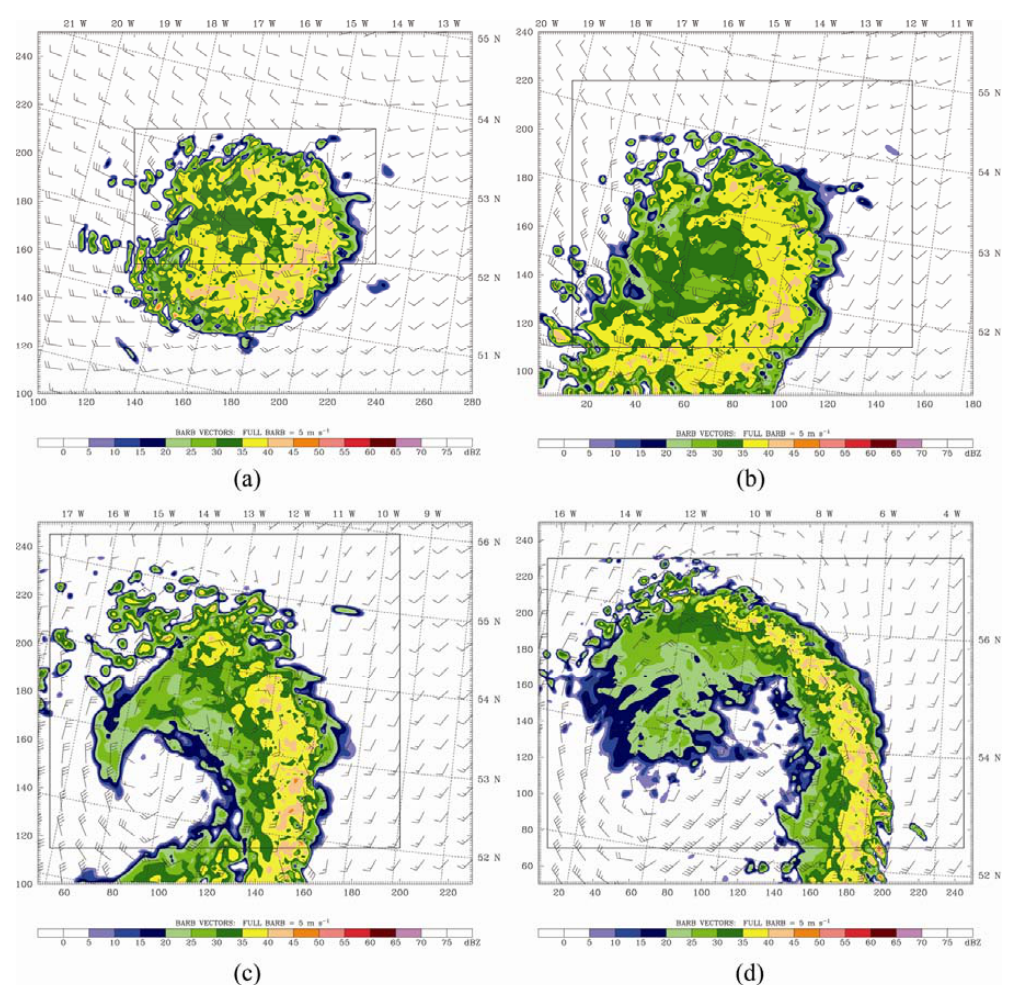
Fig. 2. Model-derived reflectivity (dBz; shading), horizontal flow (barbs; knots) at 700 hPa, and analysis boxes at the following times in the CAPE simulation: (a) 156 h; (b) 158 h; (c) 162 h; and (d) 170 h.